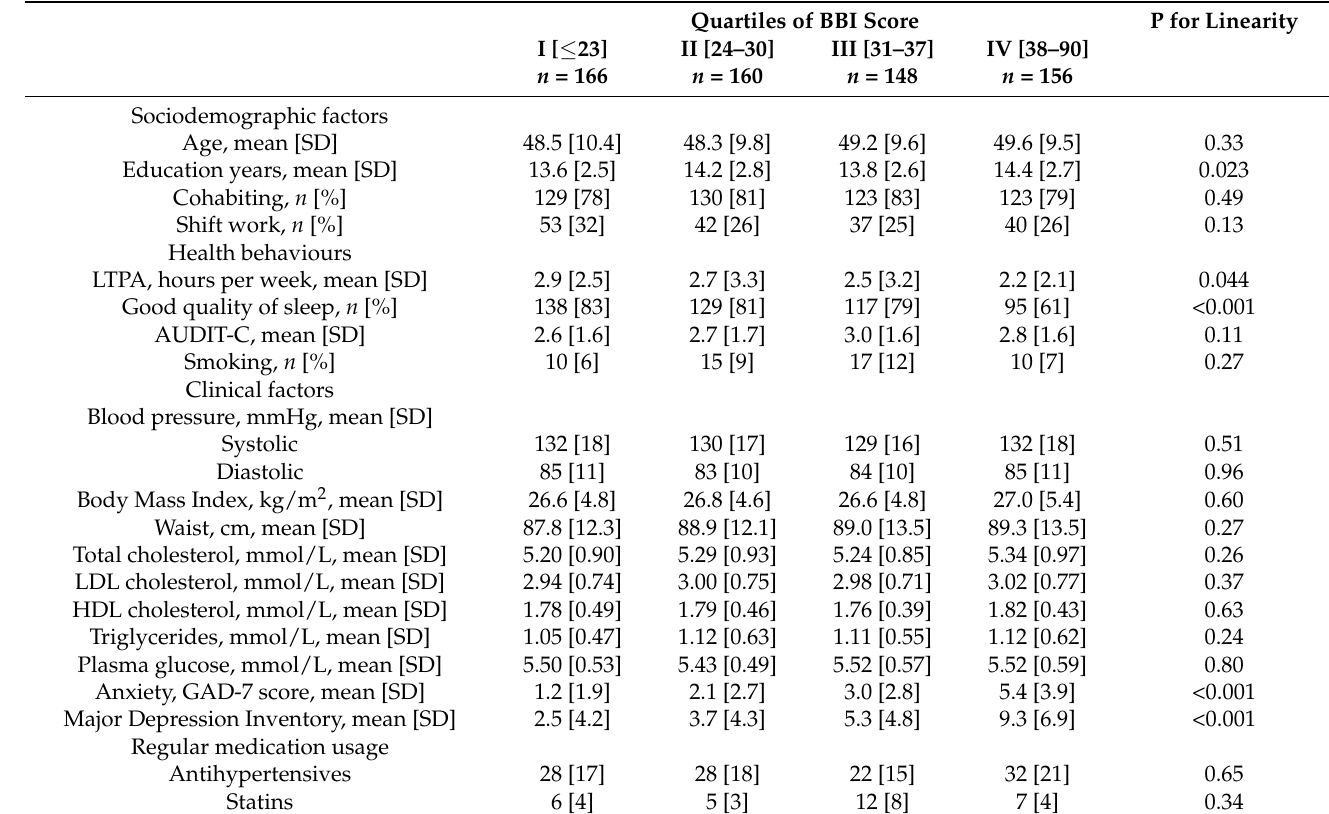
Table 2. Characteristics of the study subjects according to quartiles of the Bergen Burnout Indicator (BBI) score. Quartiles of BBI Score P for